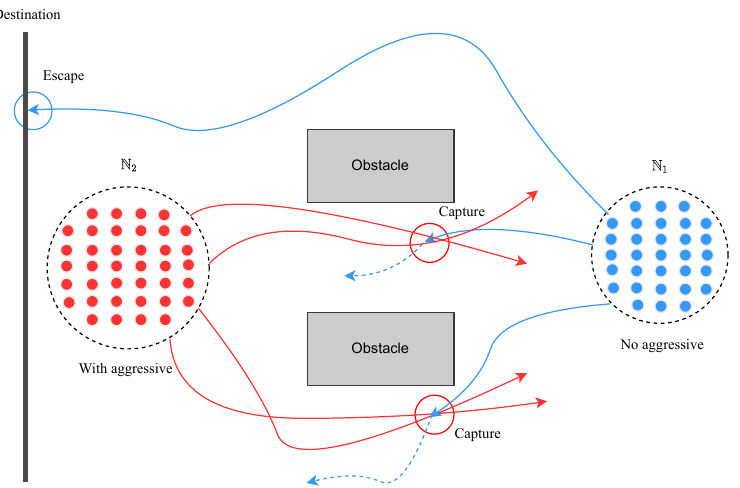
Figure 1. Vertical view of large-scale agents attacking and defending in 3D obstacle